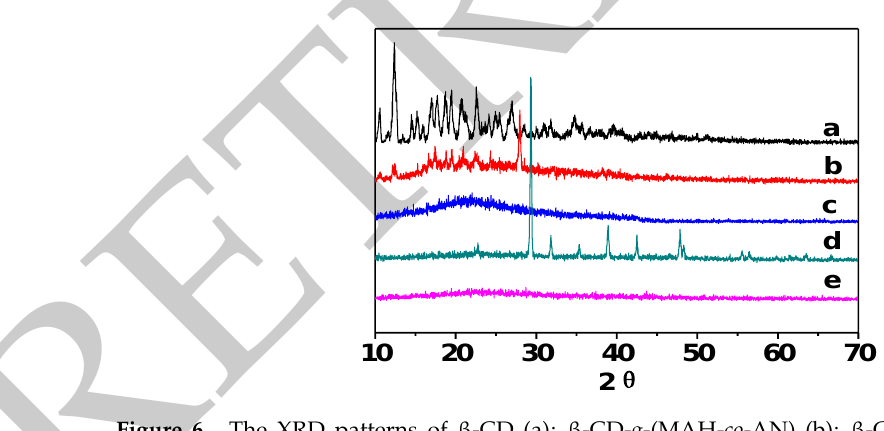
Figure 6. The XRD patterns of β -CD (a); β -CD- g -(MAH- co -AN) (b); β -CD- g -(MAH- co -AO) (c); β -CD- g -(MAH- co -AO) adsorption of U(VI) (d); β -CD- g -(MAH- co -AO) desorption of U(VI) (e).